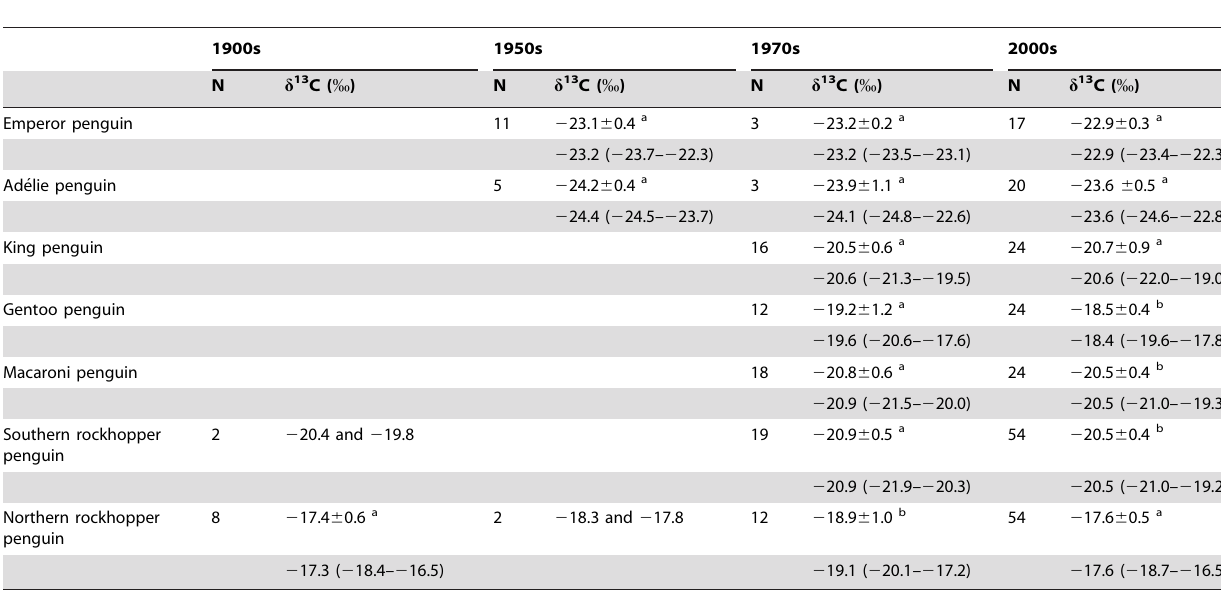
First line: values are mean 6 SD; second line: median, minimum and maximum values. Values in the same line not sharing a common superscript letter are significantly different ( p , 0.05; see text). Carbon isotopic values were corrected for Suess and increase [CO 2 ] aq effects. doi:10.1371/journal.pone.0016484.t002 PLoS ONE |